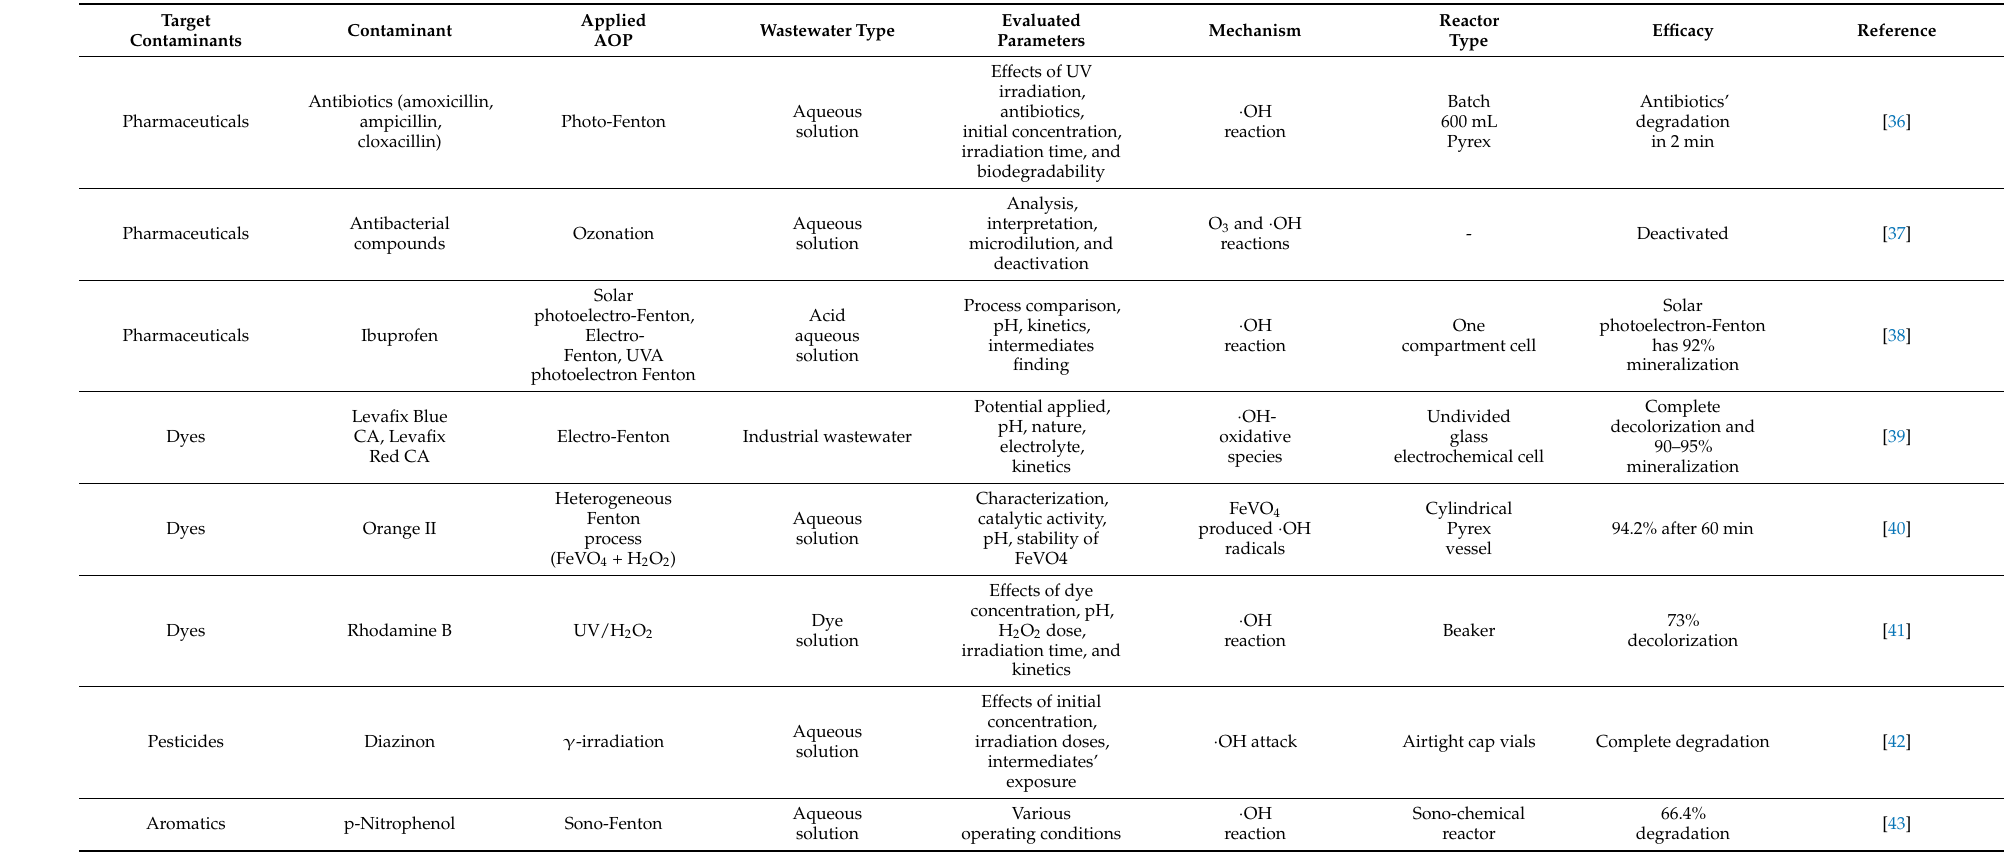
Table 3. Application of AOPs in contaminants’ removal from